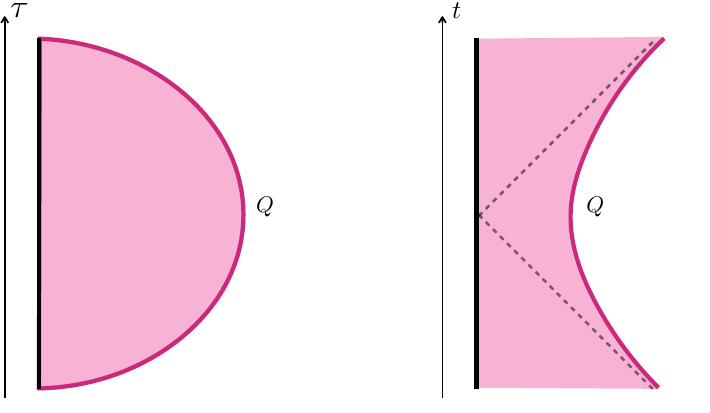
Figure 33 . The x = const . slice of the Euclidean setup and the Lorentzian counterpart at the phase transition point ∆ φ = ∆ φ c . The Lorentzian configuration turns out to be a Poincaré AdS with an end-of-the-world brane accelerating and falling towards the Poincaré